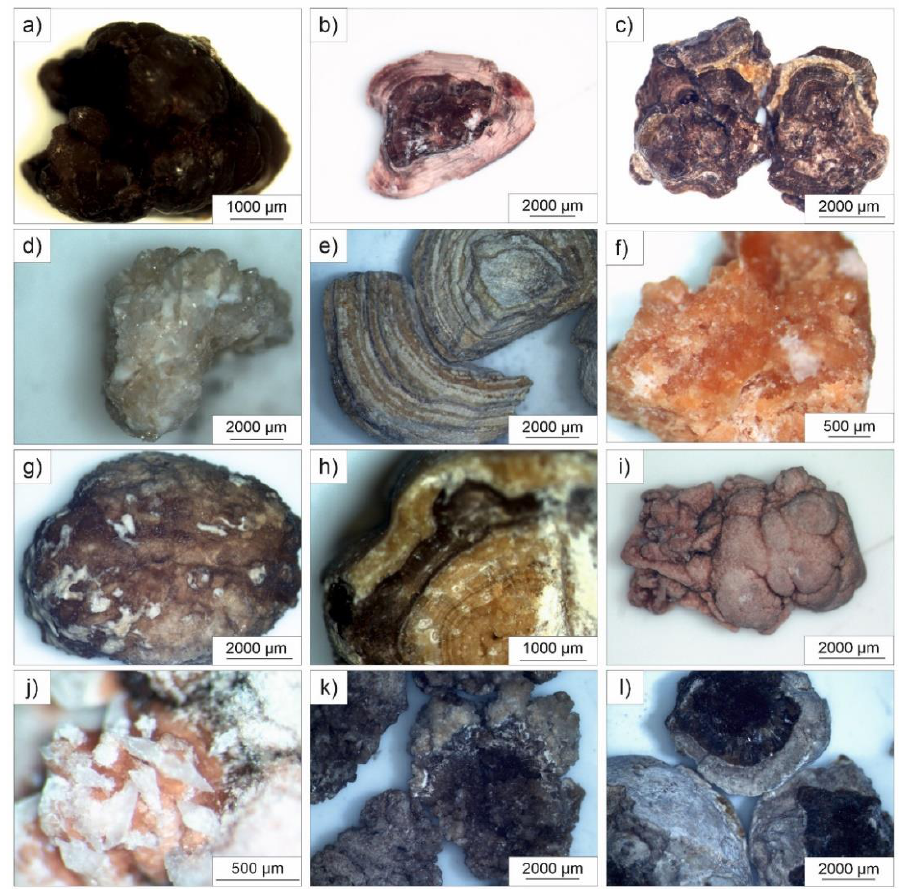
Figure 1. Micrographs of urinary stones captured in stereomicroscopy: ( a ) mammillary, dark brown type Ia calculus (KS049); ( b ) whitish thin layers of CaOx surrounding a compact concentric, dark brown core with radiating crystallization (KS004); ( c ) dark brown, compact unorganized type Ib calculus (KS021); ( d ) colorless, spiculated type IIa urolith (KS048); ( e ) orange/gray uric acid stone KS035B showing concentric structure (type IIIa); ( f ) orange uric acid stone fragment (KS003); ( g ) rough, brown surface of sample KS008 (carbonated apatite); ( h ) layers of uric acid and CaOx in sample KS039; ( i ) complex external morphology of mixed stone KS007; ( j ) bipyramidal, colorless crystals of weddellite in sample KS007; ( k ) rough and spiculated surface with unorganized internal section of bladder stone KS032B; ( l ) ammonium urate layer surrounding a compact core of CaOx with radiating crystallization in sample KS041.